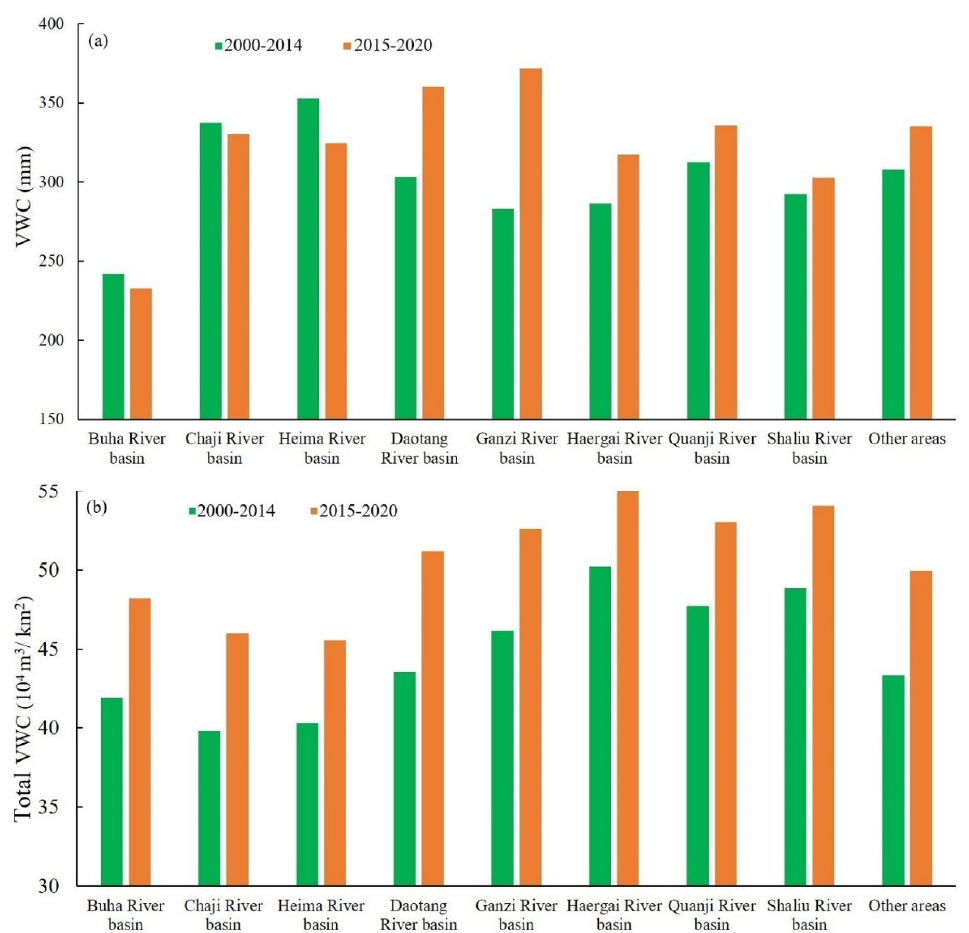
Figure 6. The VWC ( a ) and per unit area of the total VWC ( b ) in 8 sub-basins of the Qinghai Lake Basin from 2000 to 2020.